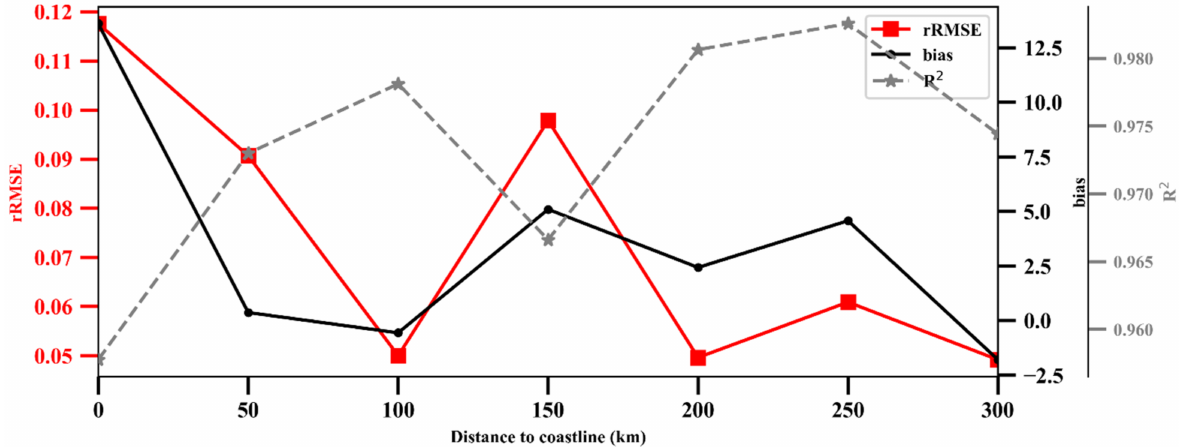
Figure 14. The same as Figure 13 but for different distances to the coastline. Taking two moored buoy sites, TAO_03 (0 ◦ N, 140 ◦ W) and OS_PAPA (50 ◦ N, 145 ◦ W),